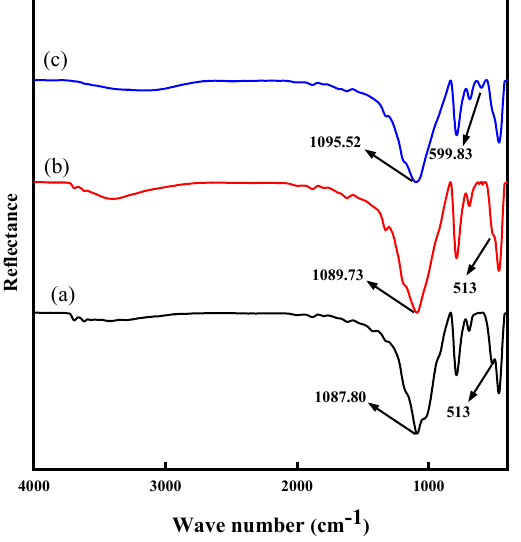
Figure 9. FT-IR spectrum: ( a ) original samples; ( b ) non-enhanced acid-leaching residues; and ( c ) enhanced acid-leaching residues.